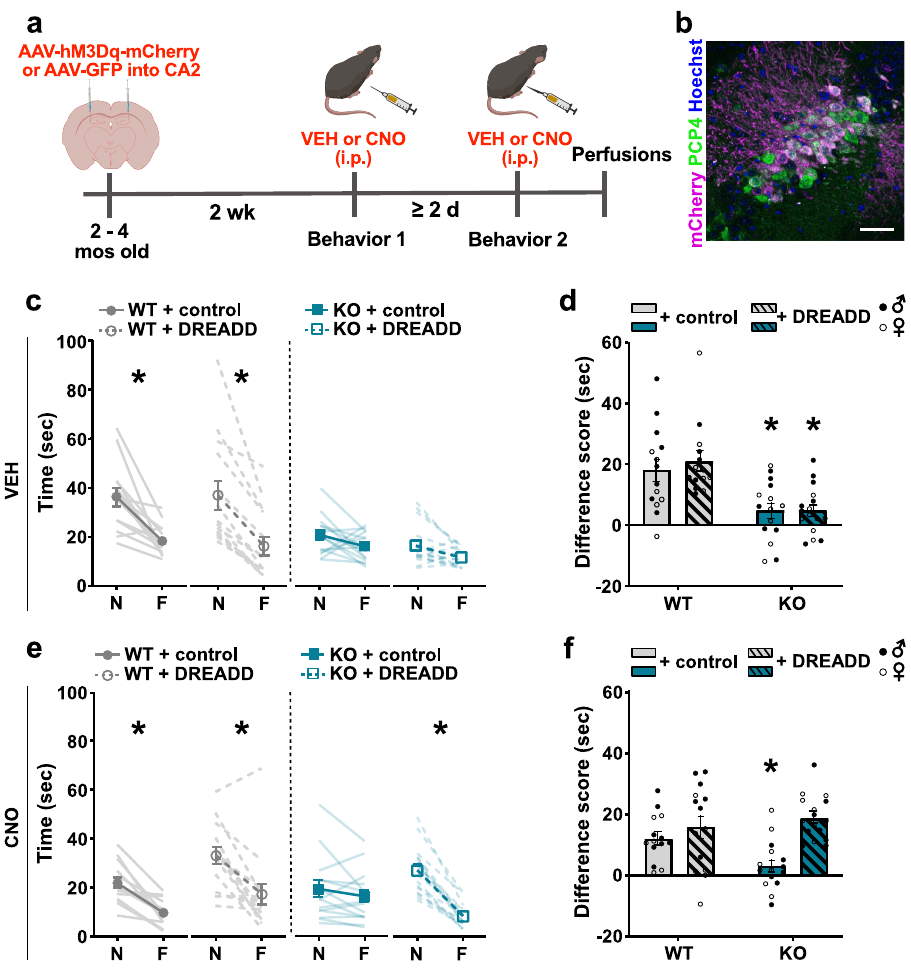
Fig. 2 | Chemogenetic activation ofexcitatory neurons in CA2 improvedsocial discriminationin Shank3B KOmice.a Timelineforexperiment. b Confocalimage from the CA2immunolabeledwith PCP4(green) and mCherry (magenta), showing localized virus infection in CA2 neurons. Scale bar = 50 µ m. c Following VEH injections, virus-infected WT micehadgreater interaction times fornovel mice (N) than familiar mice (F) (WT+control virus, p =0.0001; WT+DREADD virus, p =0.0001),whilevirus-infectedKOmiceshowednodifferenceininteractiontimes of N compared to F. d Following VEH injections, WT virus groups had higher dif- ferencescores(NminusF)thanKOvirusgroups(WT+controlvirusvsKO+control virus: p =0.0110; WT + DREADD virus vs KO + DREADD virus: p =0.0011). ( c , d , n = 14 for WT+control virus, WT + DREADD virus, n =15 for KO+control virus, and n =16 for KO+DREADD virus. e Following CNO injections, virus-infected WT mice had greater interaction times for N than F (WT+control virus, p =0.0002; WT+ DREADDvirus, p =0.0001).Controlvirus-infectedKOmicehadnointeractiontime differences between N and F, while DREADD virus-infected KO mice had